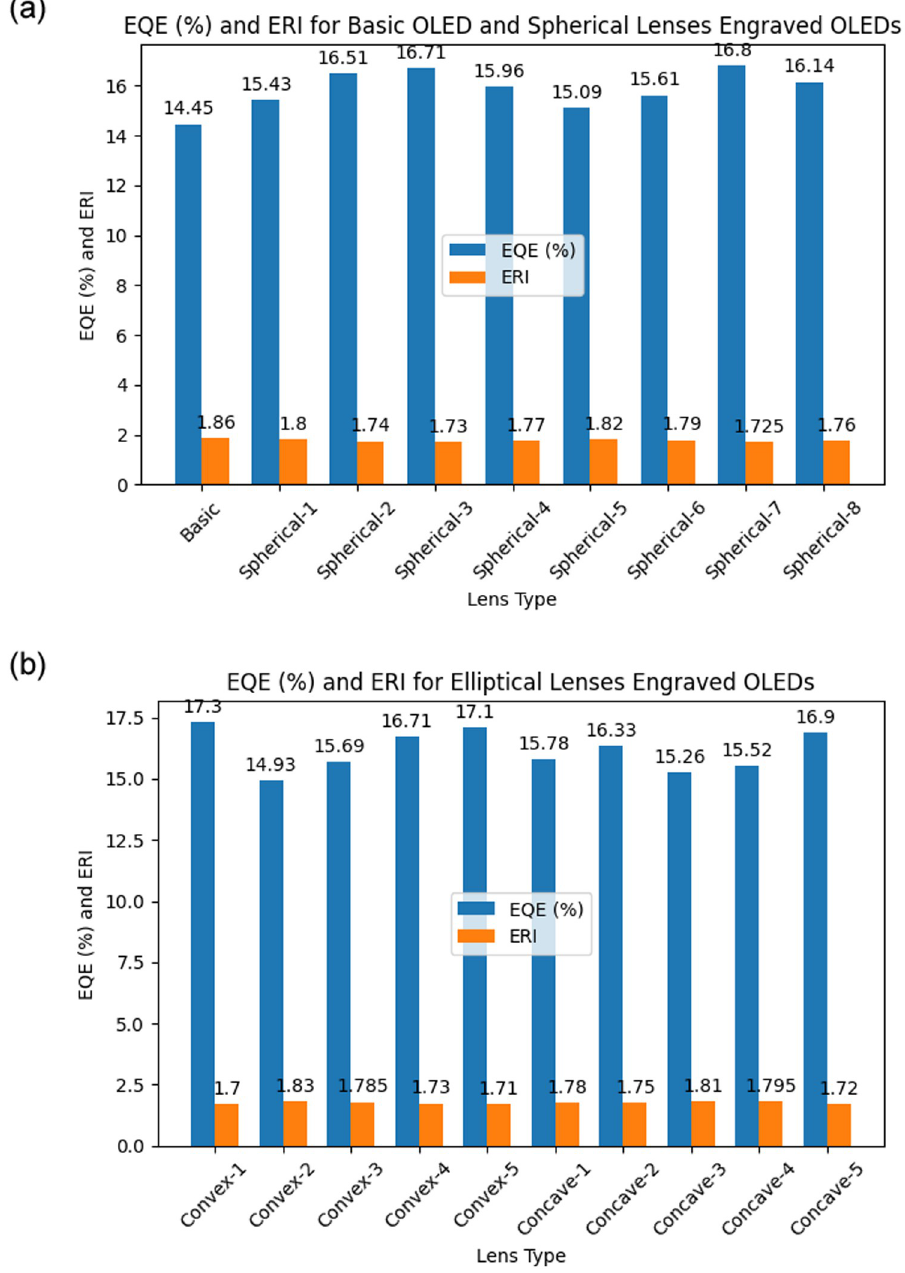
Fig 18. EQE and ERI for the OLEDs that have been designed: (a) Basic OLED and spherical MLA engraved OLEDs; (b): Elliptical MLA engraved